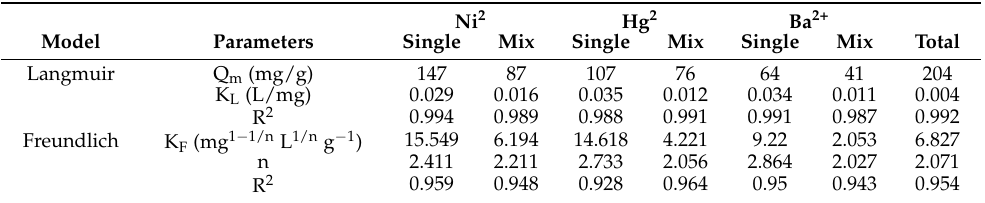
Table 6. Equilibrium parameters for Ni 2+ , Hg 2+ , and Ba 2+ adsorption (single- and multi-component aqueous solutions), onto CS-HMF